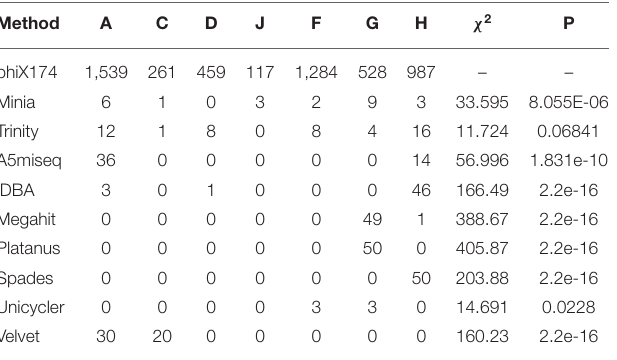
TABLE 2 | Distribution of defects among the seven gene regions. For reference, gene sizes are indicated.